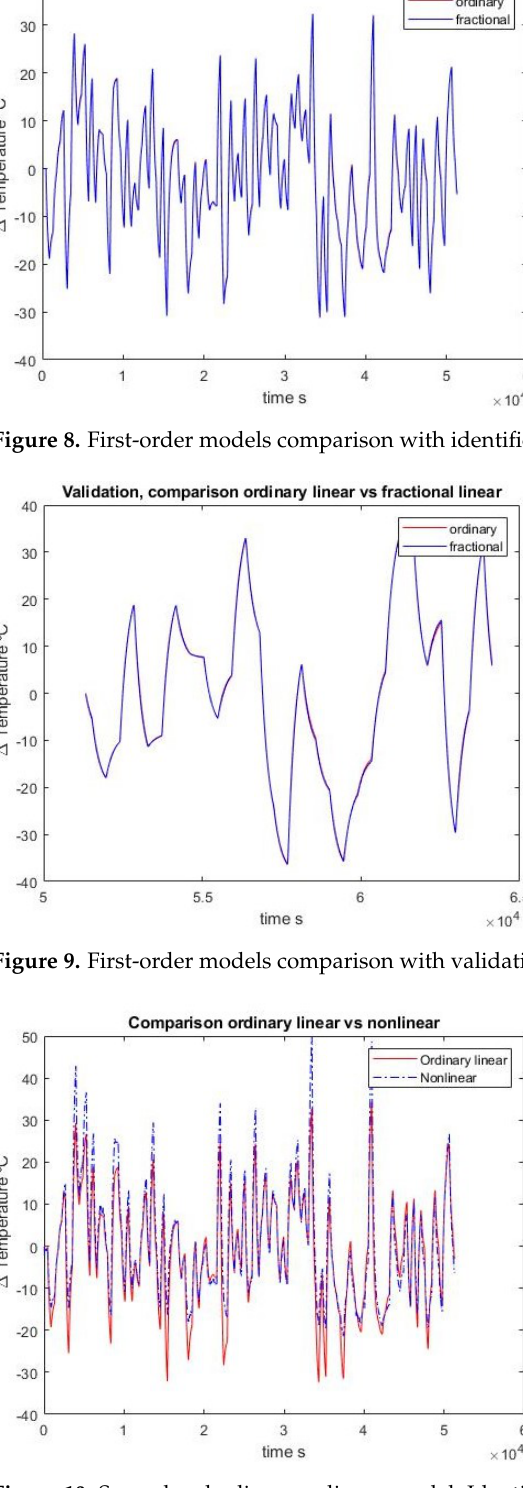
Figure 10. Second-order linear ordinary model.